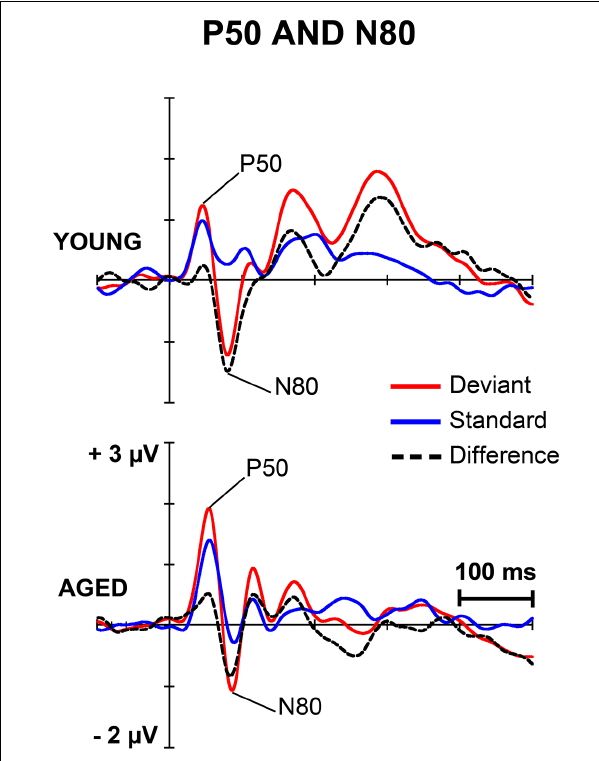
to standard and deviant stimuli were compared in paired samples t -tests separately within each age group. Within young, responses todeviantstimulidifferedsignificantlytothoseof standardstimuli at medial electrode sites, t 17 = 3.57, p = 0.002, d = 1.033. Dif- ferential responses to the two stimulus types at right hemisphere electrode sites, t 17 = 2.09, p = 0.052, d = 0.563, and left hemi- sphere electrode sites, t 17 = 1.99, p = 0.063, d = 0.477, did not reach the significance. Among aged the difference in amplitude between the ERPs to deviants and standards were not evident at any of the analyzed averaged electrode sites (medial: t 12 = 0.51, p = 0.616, d = 0.180; left: t 12 = 0.35, p = 0.736, d = 0.093; right: t 12 = 0.03, p = 0.981, d = 0.010; Table 1 ). The MMR was different in amplitude between the age groups at medial electrode sites ( F 1,29 = 6.96, p = 0.013), but not at left ( F 1,29 = 2.93, p = 0.097), neither at right ( F 1,29 = 2.05, p = 0.163)